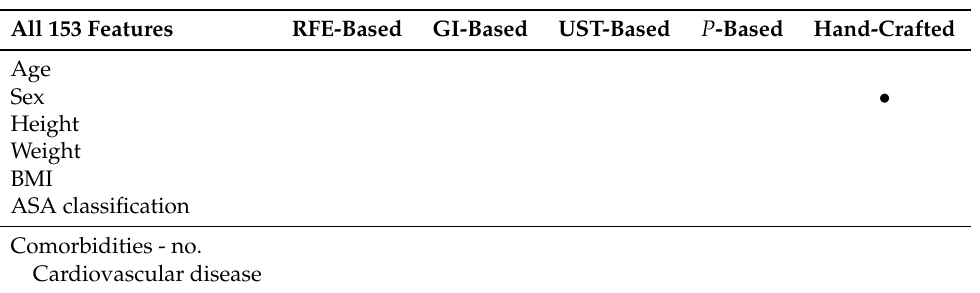
Table A1. Feature